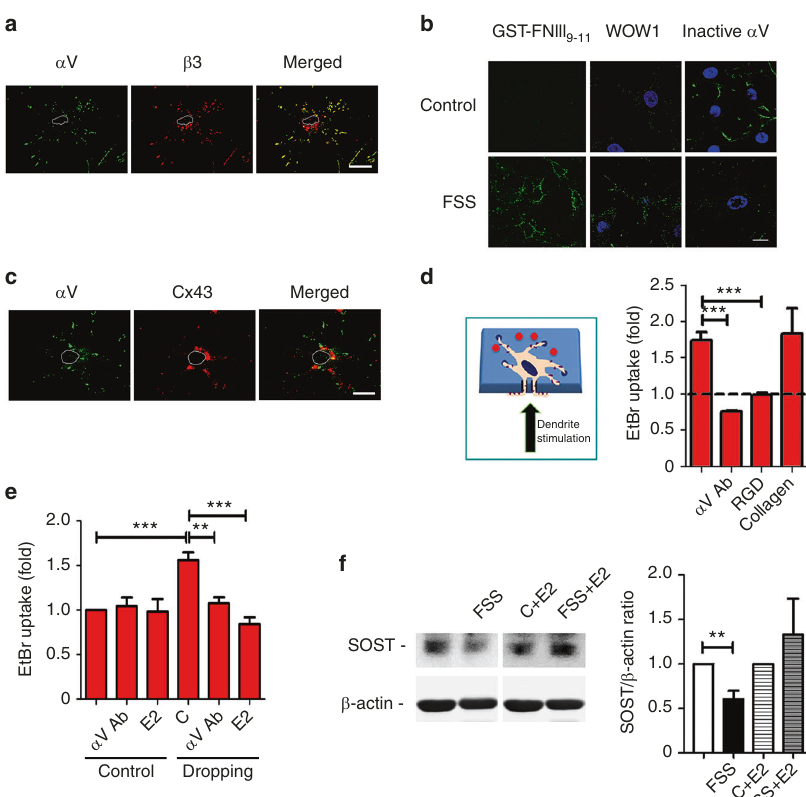
Fig. 1 Integrin α V β 3 in osteocytes plays an important role in transmitting mechanical stimulation from dendrites to HCs located on the cell body. a Integrin α V colocalizes with β 3 at the dendritic processes of osteocytes. MLO-Y4 cells were coimmunoprecipitated with an anti- integrin α V inhibitory antibody on the cell surface and with β 3 antibodies in permeable cells, followed by incubation with FITC- and rhodamine-conjugated secondary antibodies, respectively. Bar, 10 µm. b FSS activates integrin α V β 3. MLO-Y4 cells were subjected to FSS at 8 dynes per cm 2 for 30 min or not treated with FSS and then incubated with the GST-FNIII 9-11 fragment, immunolabeled with a WOW1 antibody or incubated with an antibody targeting inactive integrin α V, followed by incubation with a FITC-conjugated corresponding secondary antibody. Bar, 10 µm. c Cell surface-expressed integrin α V does not localize with Cx43 in osteocytes. MLO-Y4 cells were coimmunoprecipitated with anti-integrin α V inhibitory and Cx43 antibodies in permeabilized cells, followed by incubation with FITC- and rhodamine-conjugated secondary antibodies, respectively. Bar, 10 µm. d Activation of integrin α V by mechanical loading in dendritic processes opens HCs on MLO-Y4 osteocyte cell bodies. MLO-Y4 cells cultured on transwell fi lter inserts were pretreated with an α V inhibitory antibody ( α V Ab), 500 μ mol·L − 1 RGD peptide, or 2.5 μ g·mL − 1 collagen for 15 min. The cells were mechanically stimulated by dropping solution on the dendritic processes (bottom) side of the transwell fi lter (left panel), after which EtBr was added, and its uptake was quanti fi ed (right panel). The basal level of the dye uptake is indicated by the dashed line. The data are presented as the mean ± SEM. n = 3. ***, P < 0.001. e Activation of integrin α V by mechanical loading via liquid dropping opened HCs in IDG-SW3 osteocytes. Differentiated IDG-SW3 osteocytes were pretreated with an α V inhibitory antibody ( α V Ab) or a Cx43 (E2) antibody for 15 min. The cells were mechanically stimulated by dropping solution, and EtBr uptake was quanti fi ed. The data are presented as the mean ± SEM. n = 3. *, P < 0.05; ***, P < 0.001. f HCs activated by FSS inhibited SOST expression. IDG-SW3 cells were treated with FSS for 2 h in the absence or presence of a Cx43(E2) antibody. Four hours after FSS, cell lysates were prepared and immunoblotted with an anti-SOST or anti- β -actin antibody (left panel), and band intensity was quanti fi ed (right panel). The data are presented as the mean ± SEM. **, P < 0.01. n =